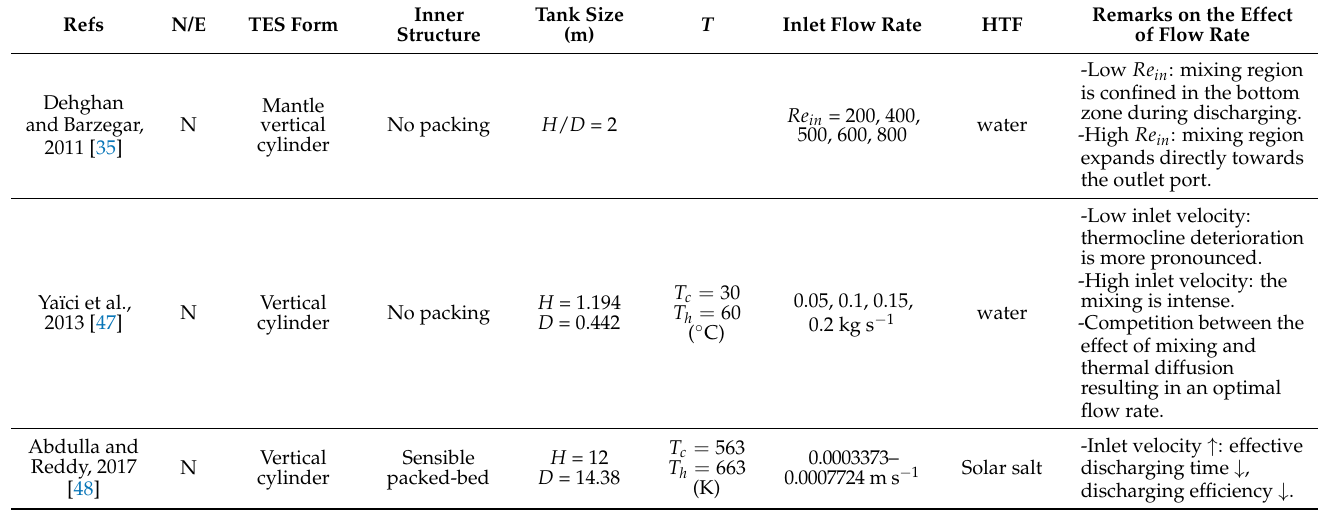
Table 3. Study on the influence of flow rate for thermocline-based TES